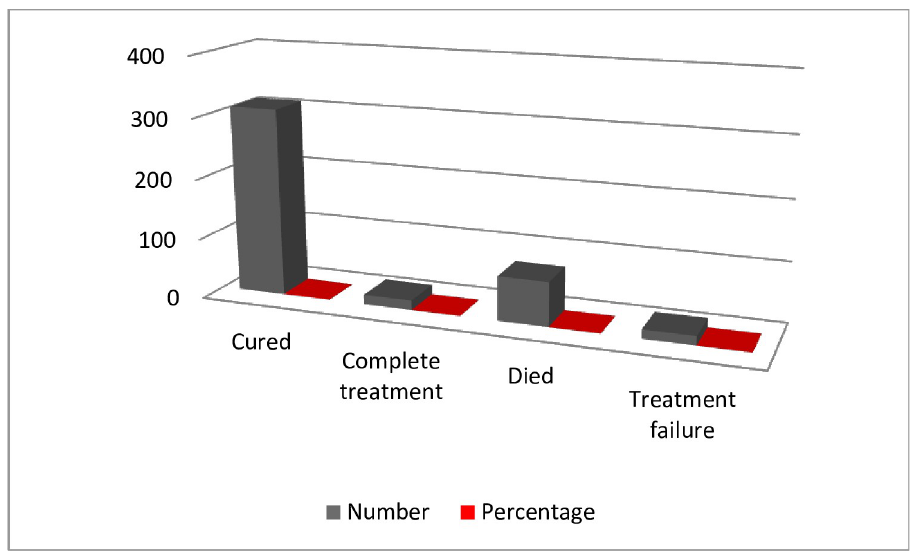
Fig 1. Treatment outcome of MDR-TB patients stratified by treatment outcome in Oromia hospitals from 2012 to 2017, Oromia Ethiopia. were diagnosed by using Line Probe Assye. Near to three fourth of patients, 286 (68.9%) were mono drug resistant (for Isoniazid) whereas near to one four of patients 93 (22.4%) were two drug resistant and treated with regimen of Z+E+Cm+Lfx+Eto+Cs (Table 2). Treatment outcomes and time to unfavorable treatment outcome Of the 415 MDR-TB patients, 311 (69.6%) were cured, 16 (3.6%) were completed treatment, 73 (16.3%) were died, and 15 (3.4%) had treatment failure (Fig 1) . Four hundred fifteen MDR TB patients were followed for median of 20 months with a total of 7877 person months. During these periods, 88 (21.21%) unfavorable treatment outcome and 327 (78.8%) favorable treatment outcome were occurred. The median time to unfavorable treatment outcome was 7 months, indicating unfavorable treatment outcome occurred during the intensive phase of treatment i, e. within the first eight months of treatment. One out of twenty patients lost from the treatment and the reason for lost to follow-up was not recorded. But 6 (26%) developed adverse side effects, nausea, vomiting, muscle pain and joint pain before lost to follow up. The overall cumulative probability of survival at the end of 12 months was 86.4% (95% CI: 84.7, 88.1), at the end of 24 months was 74.8% (95% CI: 71.9, 77.7) and at the end of 36 months was 55.00% (95% CI: 42.1, 67.9) (Fig 2). HIV positive MDR TB patients had a shorter survival time than HIV negative patients (P = 0.000). The cumulative probability of HIV positive MDR TB patients at the end of 24 months was 38.7% (95% CI: 30.3, 47.1), the cumulative probability survival of HIV negative MDR TB patients at the end of 24 months was 83.2% (95% CI: 80.6, 85.5) (Fig 3) . Multidrug TB resistance patients with BMI less than or equal to 18 at the time of treatment commencement had a shorter survival time than MDR TB patients with BMI greater than 18 (P = 0.000). The cumulative probability of MDR TB patients with BMI less than or equal to 18 at the end of 8 months was 86.8% (95% CI: 85.1, 88.5), the cumulative probability survival of MDR TB patients with BMI greater than 18 at the end of 8 months was 91.5% (95% CI: 87.4, 95.6) (Fig 4) .